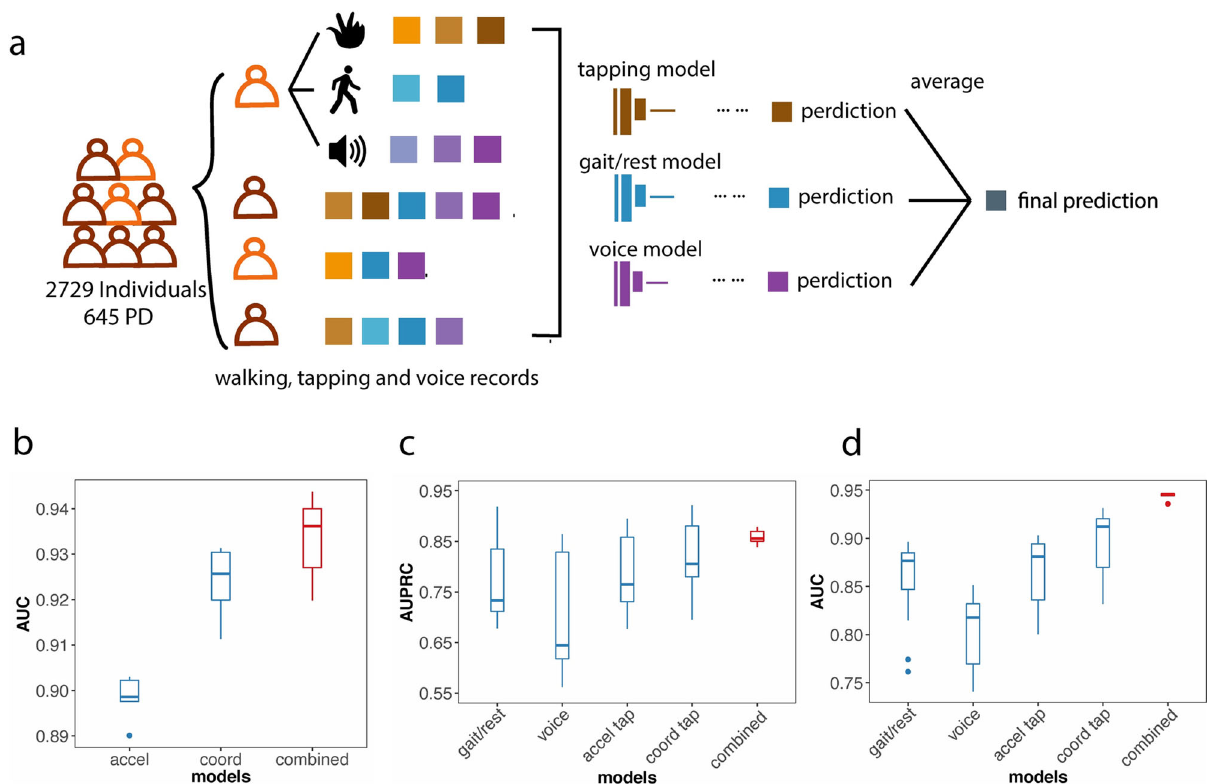
Fig. 4 Combining tapping, voice and gait/rest data improves performance in diagnosing PD. a A total of 2729 individuals (645 PD) who had all three types of data were split into the same cross-validation folds and to train gait/rest, voice, and tapping models. The models are combined together by averaging the prediction scores from each model. b Assembling accelerometer and coordinate tapping data models exceeds the performance of either single model. ( c ) and ( d ) depict the comparison among gait/rest, voice, tapping, and assembled models. The combined model achieves the best